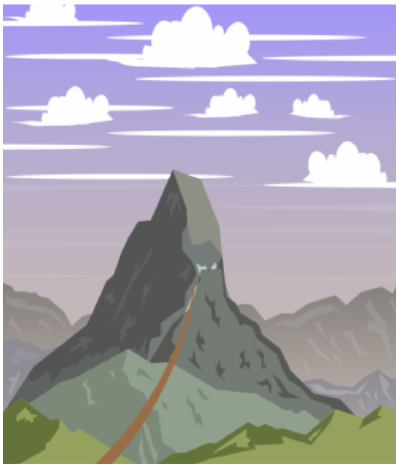
Figure 2. Interface of the game “Walking on the Rope”.